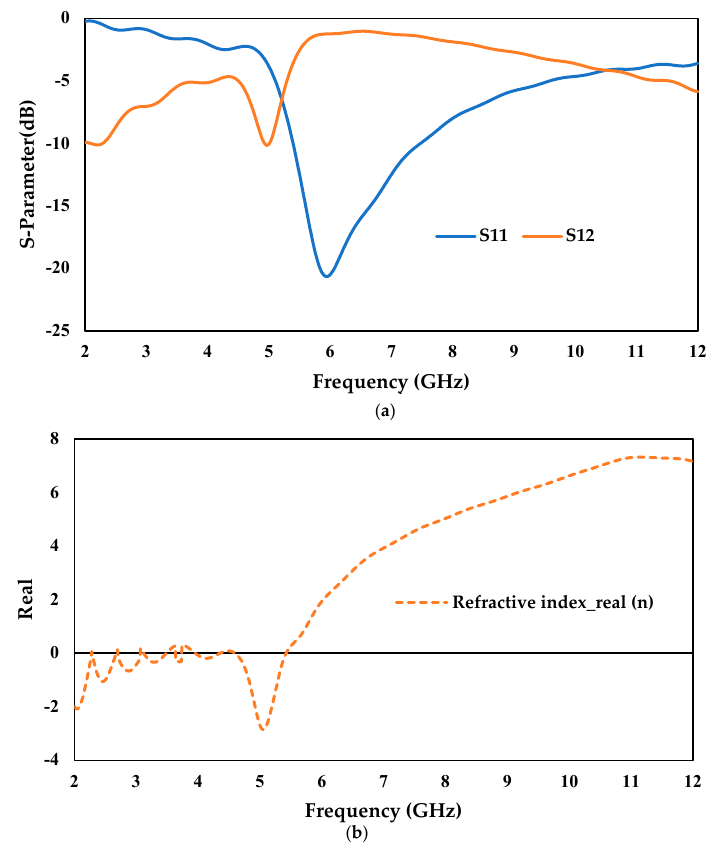
Figure 3. Performance analysis of SSRR unit-cell ( a ) S-parameter response ( b ) Refractive index response.